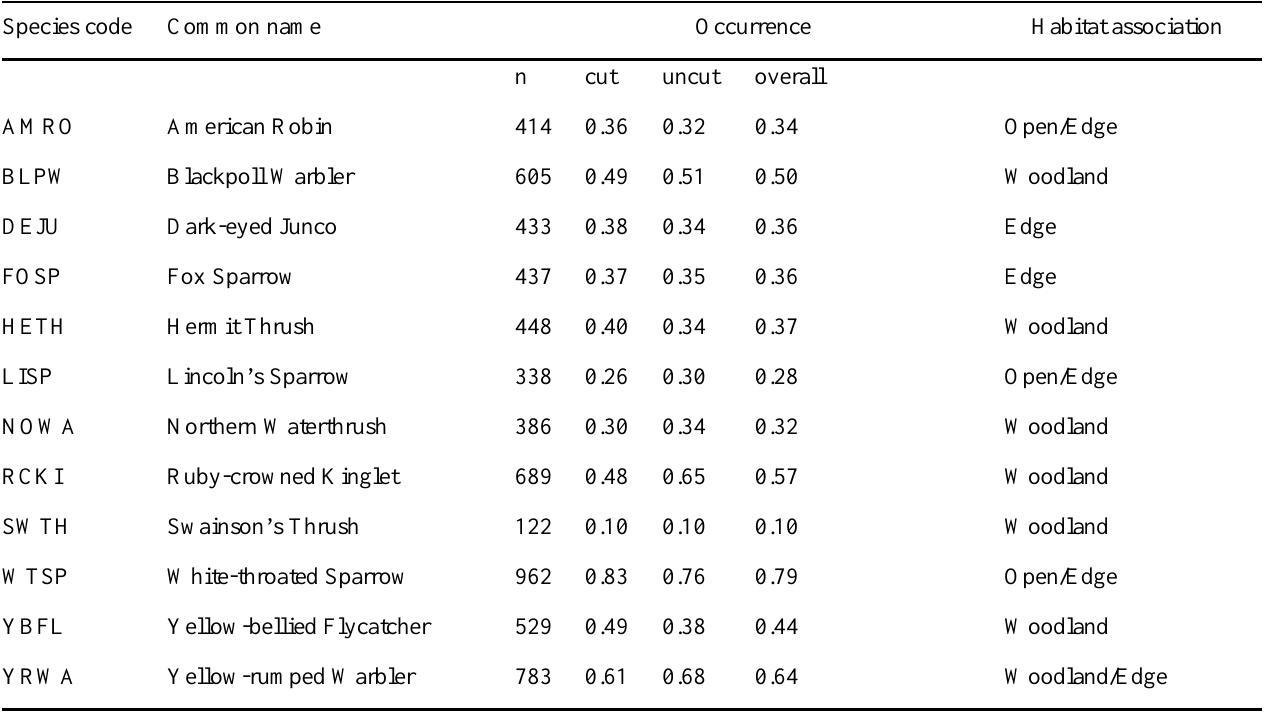
Table 1. Summary of species occurrence and general habitat associations (literature derived) in western Newfoundland, 1998–2000 (n = 1214 point